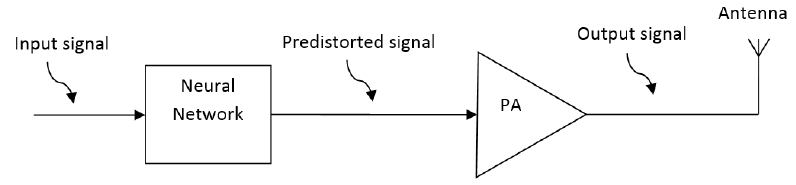
Figure 9. Digital predistorter (DPD) technique using a neural network.